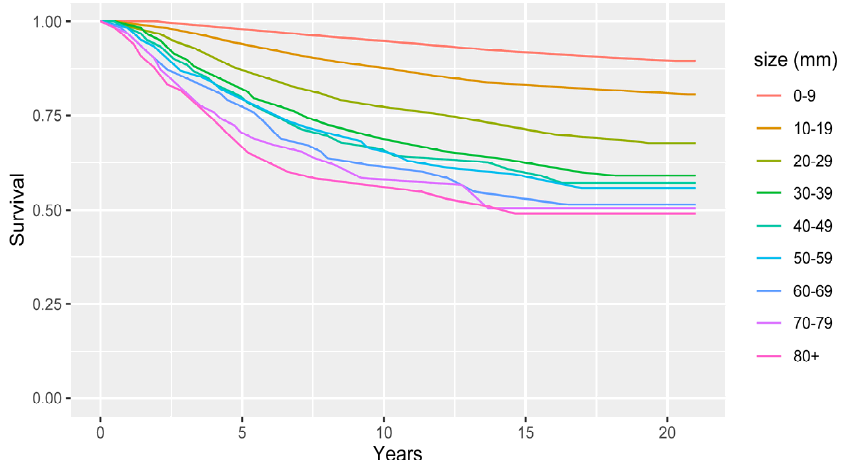
Figure A1. Kaplan-Meier curves for lymph node-negative (N0) breast cancer survival, stratified by primary tumour size.